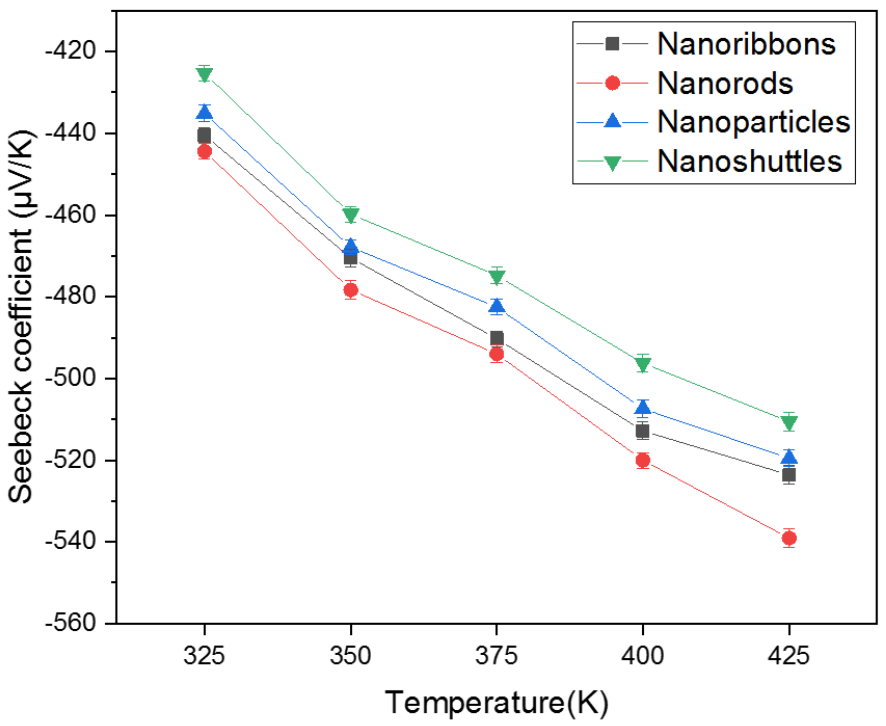
Figure 3. Temperature-dependent Seebeck coefficient of ZnO nanoribbons, nanorods, nanoparticles, and nanoshuttles.